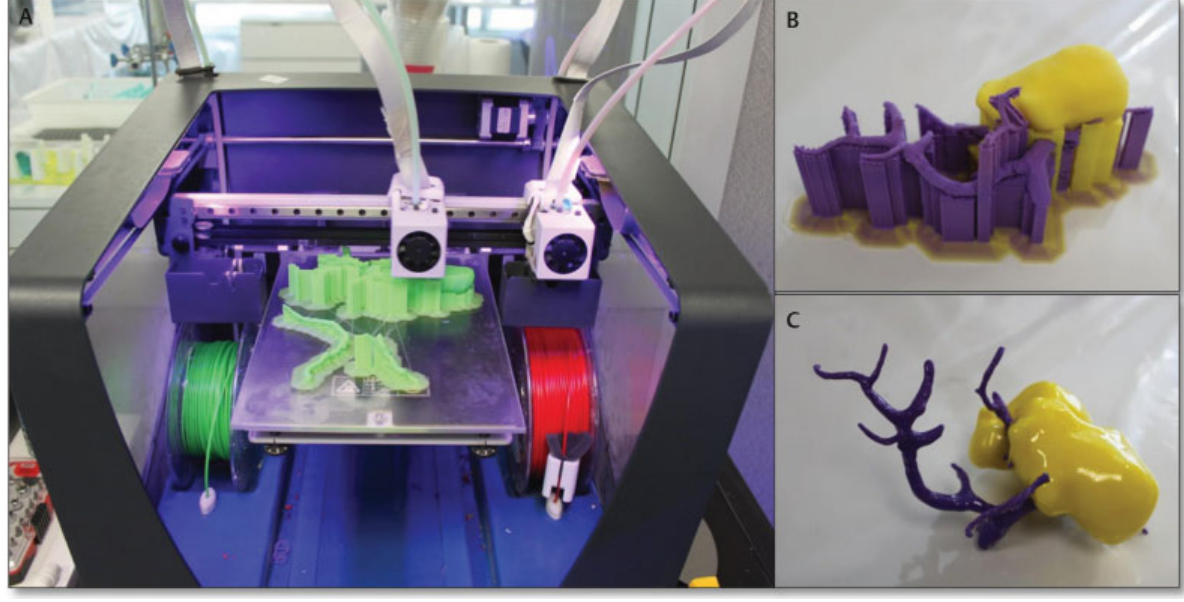
Fig.1 Different steps of 3D printingare shown. ( A ) FDM printer; ( B ) printed structure still with support material. ( C ) Result after post-processing the piece. FDM, fused deposit modeling; 3D,